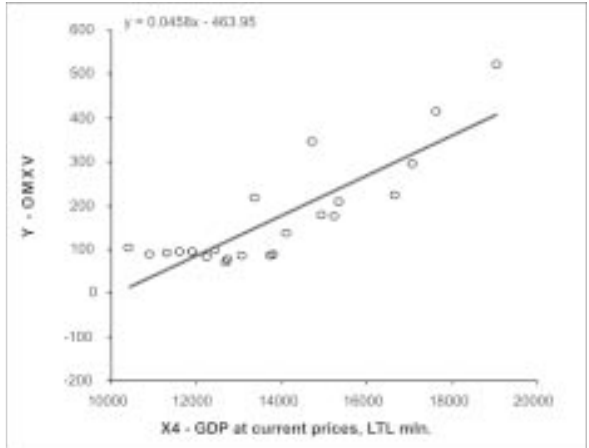
Fig 4. Dependence of OMXV index on M2 (mill. Lt)